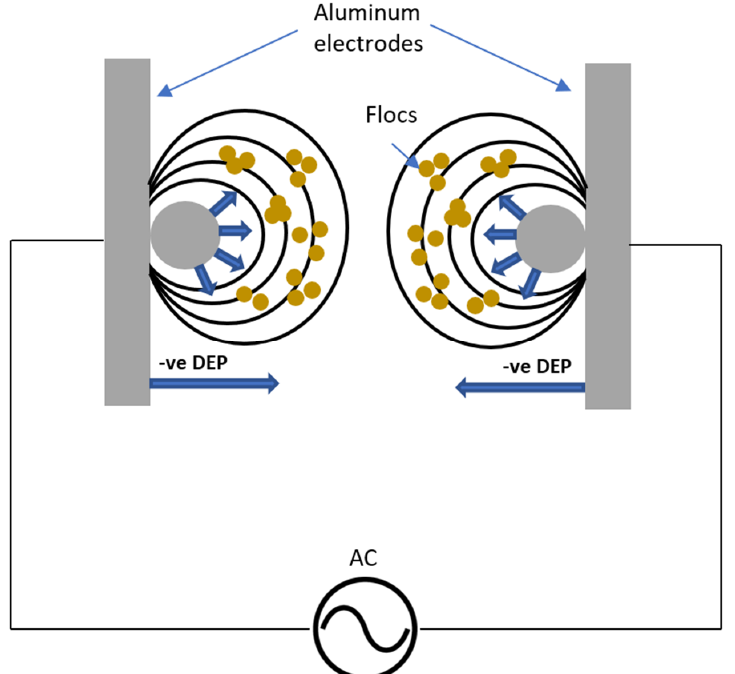
Figure 10. The removal percentage of Fe and Mn using variable applied current, electrolysis time 30 min and electrode spacing 0.5 cm. ( a ) Fe removal percentage; ( b ) Mn removal percent- age.